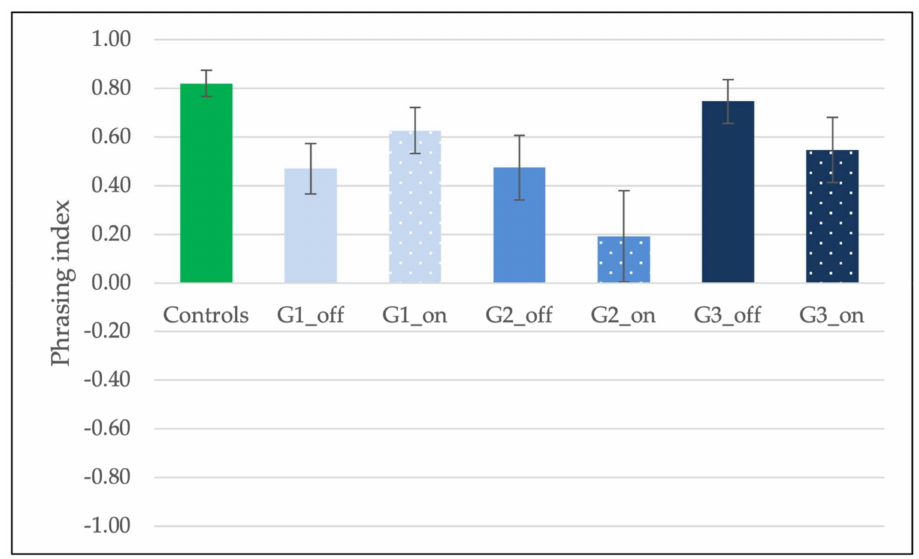
Figure 5. Average prosodic phrasing index across groups (Controls, and the three groups of patients, G1, G2, and G3) and medication conditions (medication-OFF and medication-ON). Error bars indicate the standard error of the mean ( ±